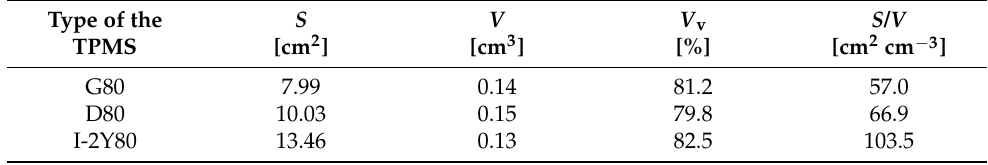
Figure 3. Visualization of the cellular lattice model with TPMS architecture: ( a ) G80; ( b ) D80; ( c ) I-2Y80. Table 1. The basic parameters of the real cellular lattice with TPMS architecture, where: S —geometric surface area, V —volume of the model, V v —total porosity of the model, S / V —surface area to volume